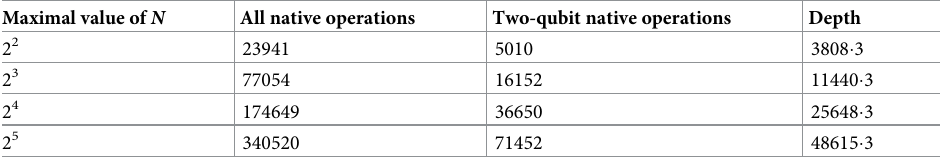
Table 3. Resource estimation for Shor’s algorithm on trapped-ion platform. Maximal value of